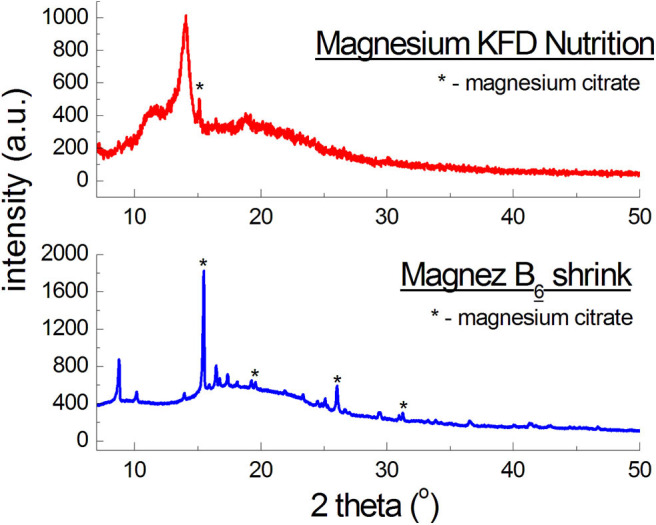
X-ray diffraction pattern for dietary supplements containing magnesium citrate [Mg3(C6H5O7)2].